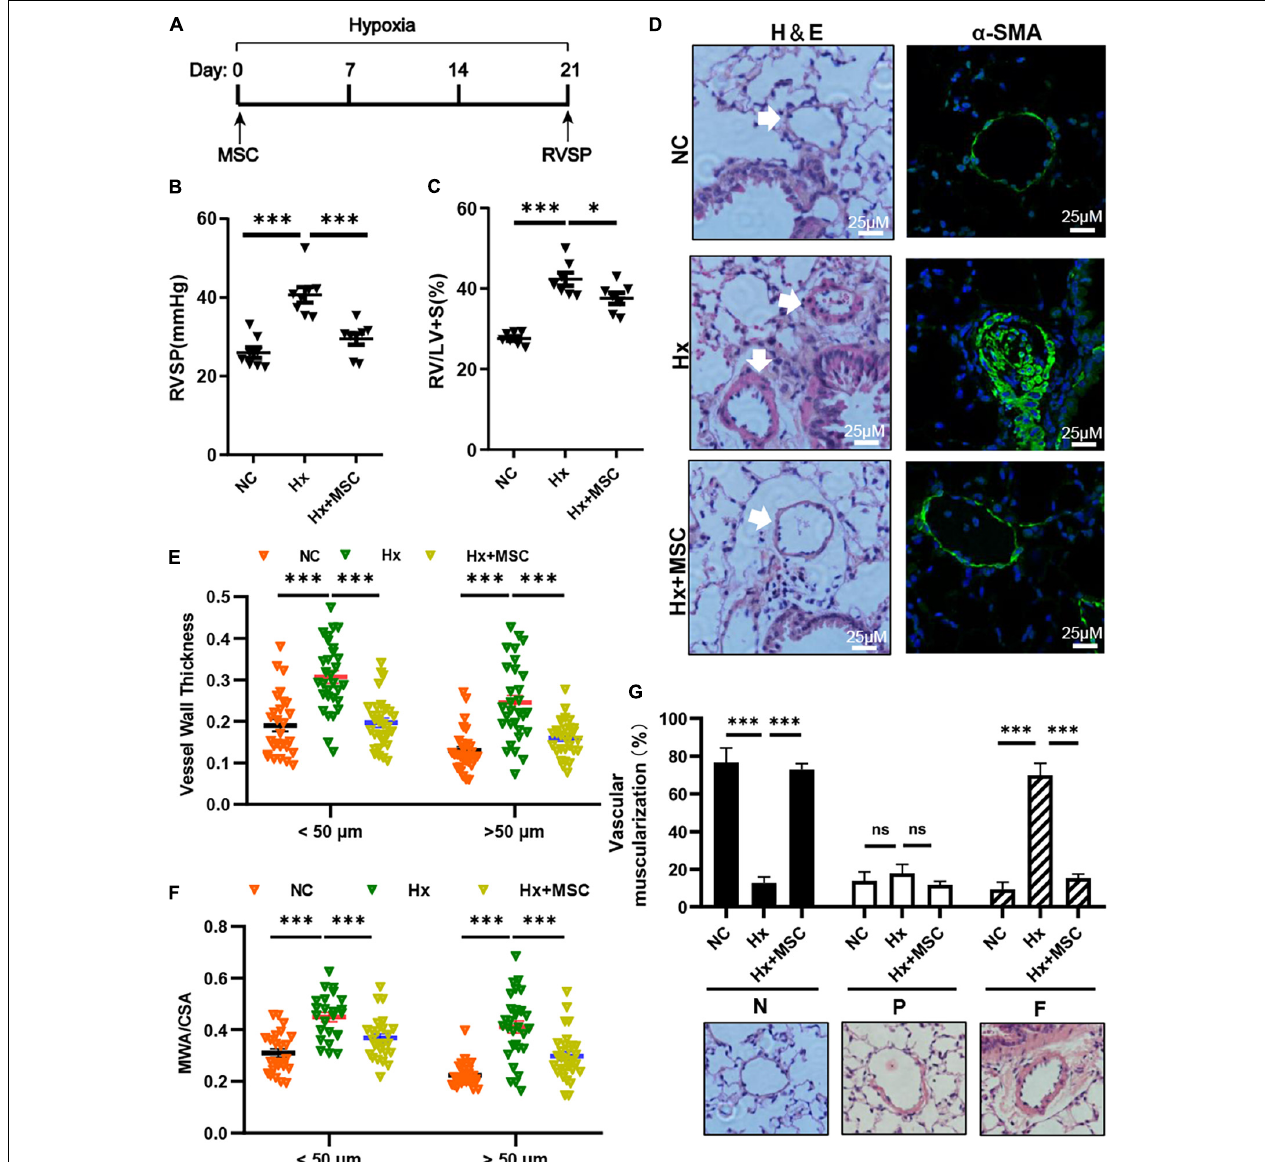
FIGURE 1 | MSCs attenuate the development of hypoxia (Hx)-induced PH in mice. (A) Protocol for the administration of MSCs to Hx-challenged mice. (B,C) Effect of MSC administration on RVSP and the RV/LV + S ratio in hypoxia-induced PH mice. ∗ P < 0.05, ∗∗∗ P < 0.001 ( n = 7). (D) Representative hematoxylin and eosin-stained lung sections and immunofluorescence images of α -SMA (green) expression in Hx-induced mice treated with MSCs. Scale bars: 25 µ m. (E) Quantification of the vessel wall thickness of the pulmonary artery. ∗∗∗ P < 0.001. (F) Quantification of the ratio of the medial wall area (MWA) to the total vessel cross sectional area (CSA). ∗∗∗ P < 0.001. (G) Proportion of non- (N), partially (P), or fully (F) muscularized PAs in the total counted PAs. A total of 30–50 vessels were analyzed in each mouse ( n = 4–6), ∗∗∗ P < 0.001. Data are presented as the mean ± SEM. Statistical significance was evaluated by t